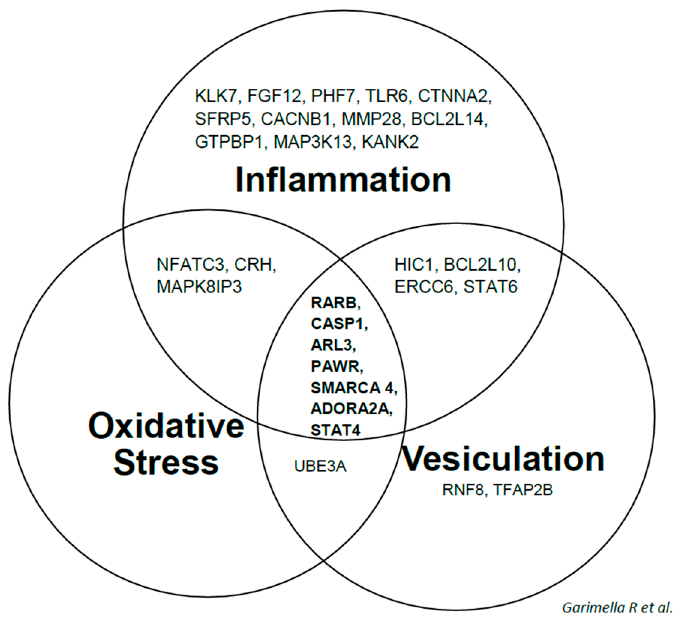
Figure 4. Venn diagram showing the most significant 1 α ,25(OH) 2 D 3 regulated genes which interact with IPA constructed inflammation, oxidative stress and vesiculation networks of key molecules that were expressed during proliferation, post-proliferation and differentiation of 143B OS cell